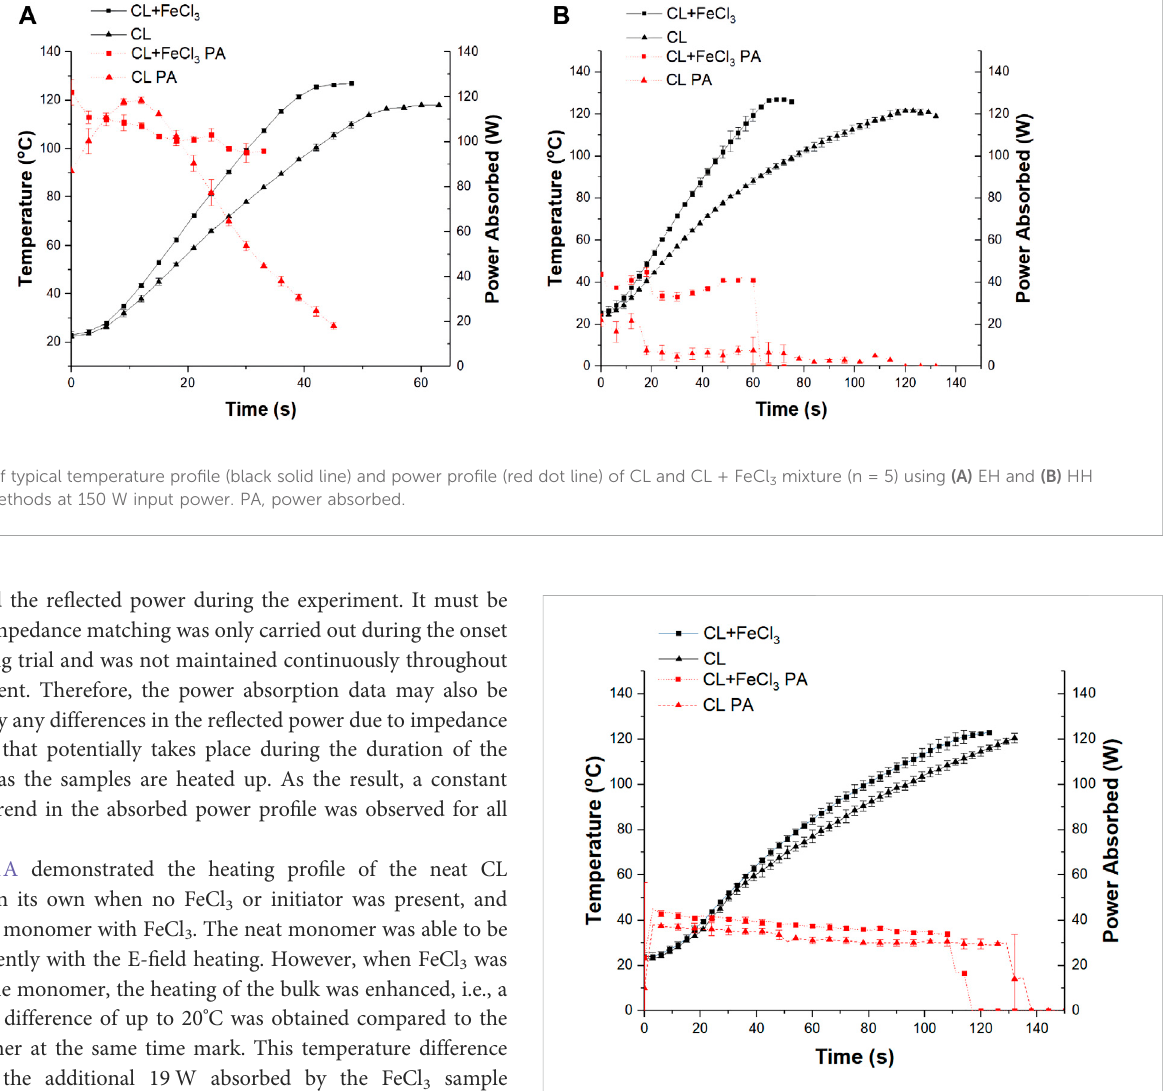
FIGURE 2 Temperature pro fi le (black solid line) and power pro fi le (red dot line) of CL and CL + FeCl 3 mixture (n = 5) using EH at 50 W input